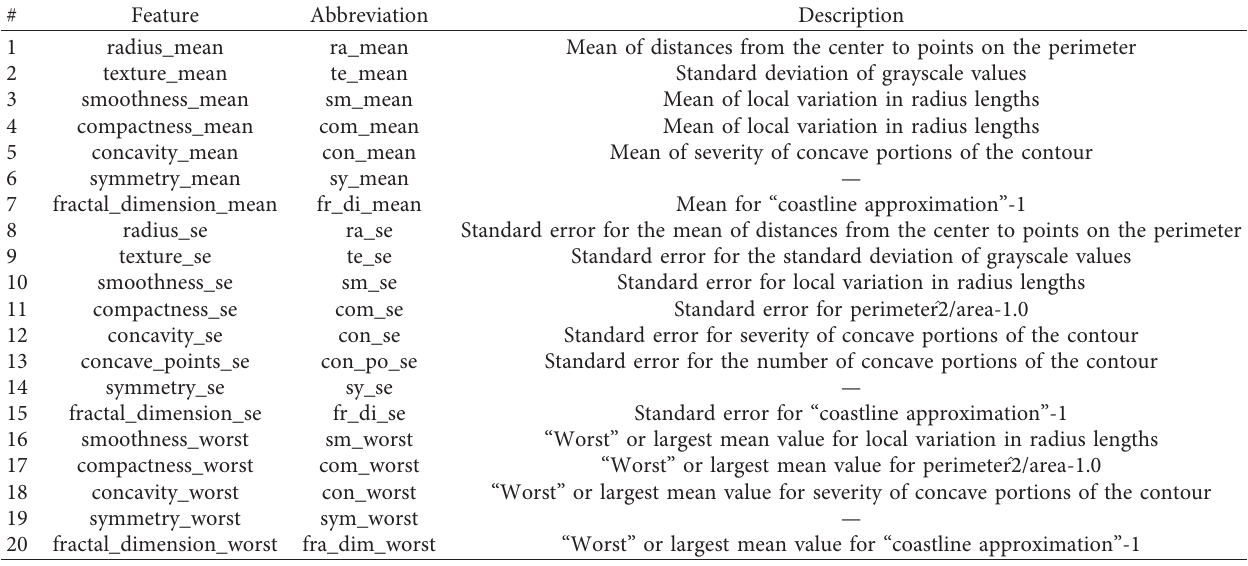
Table 1: The features’ description of the